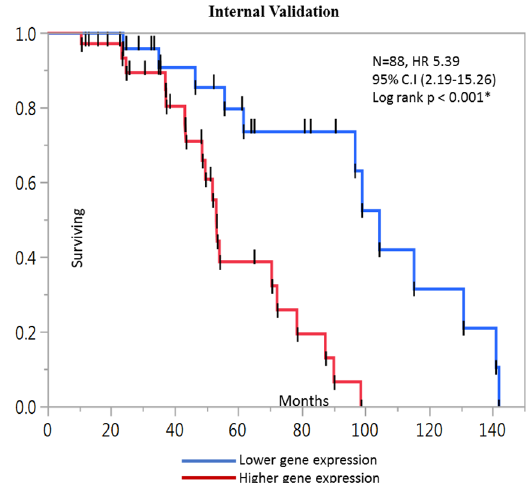
Figure 2. The composite prognostic score differentiated CRC patients ( n = 88) based on OS. The patients with higher score had poor prognosis compared to lower ones.